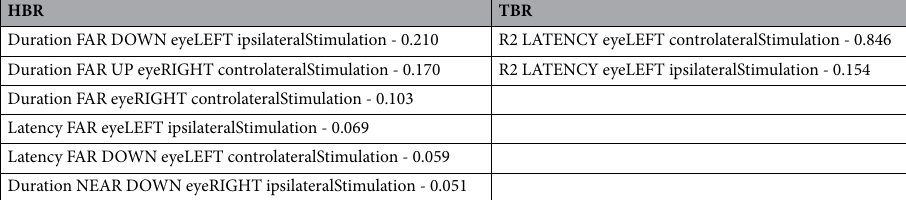
Table 2. Feature importance scores. The features selected for the classification tasks using HBR or TBR data are sorted based on their importance. For brevity purposes, the HBR column only reports those features that achieve an average importance score greater than 0.05. These are the most important ones for the classification task.